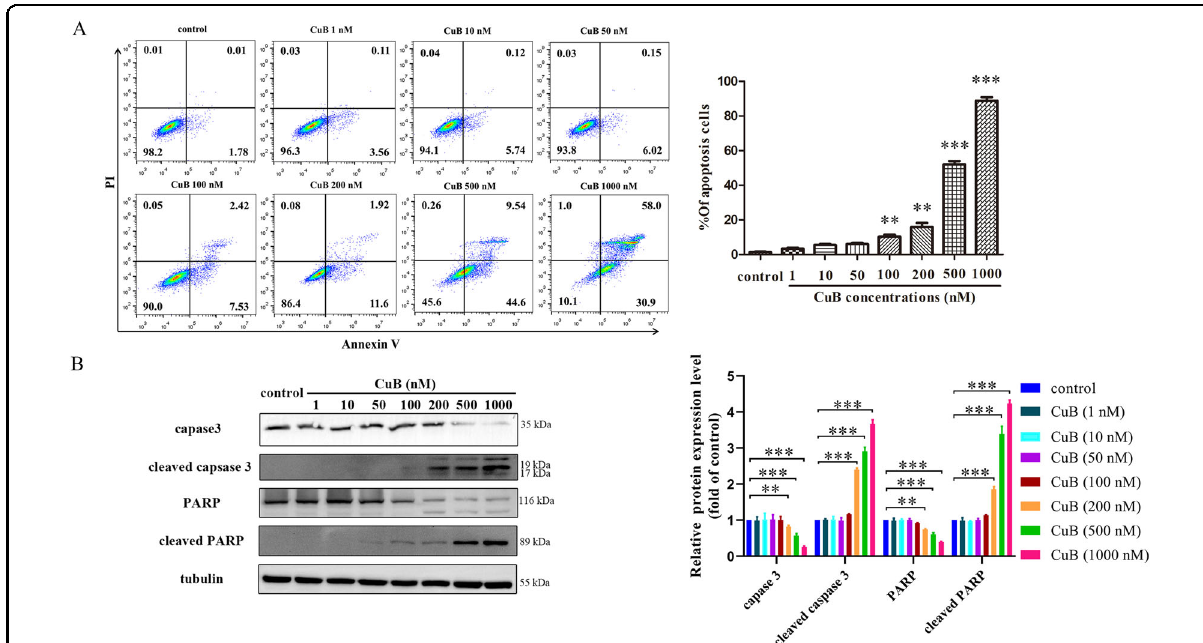
Fig. 2 The apoptosis-inducing effect of CuB. CNE1 cells were treated with or without CuB (1, 10, 50, 100,200,500 and 1000 nM) for 48 h. Then, the cells were harvested, stained with Annexin V-FITC/ PI solution for fl ow cytometer analysis ( A ), or lysed to harvest the total proteins for the western blot analysis of caspase-3, cleaved caspase-3, PARP, and cleaved PARP. B A minimum of 10,000 cells were collected for analysis by fl ow cytometer (Navios, Beckman Coulter). Quantitative analysis was performed by Image J (NIH, MD, USA). Data were presented as the mean ± SEM of three independent experiments. ** p < 0.01 and *** p < 0.001 vs . the control group by t -test using GraphPad Prism 5.0.